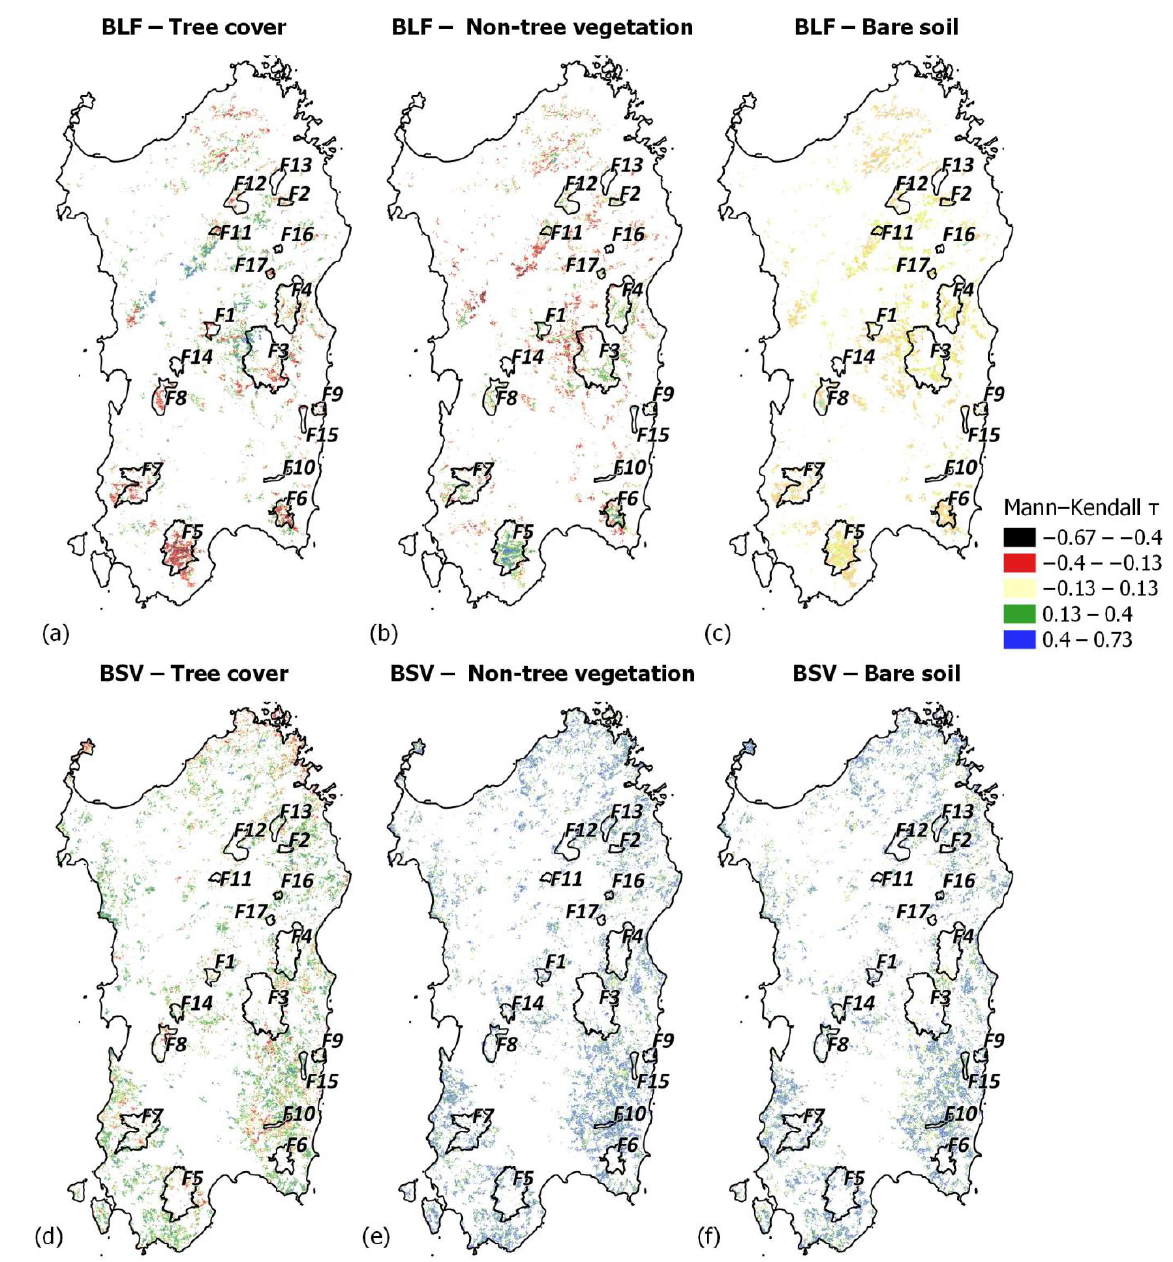
Figure 4. Mann‒Kendall τ of the percentage of tree cover ( a ), non-tree vegetation ( b ), and bare soil ( c ) for all the observed pixels classified as broad-leaved forests (BLFs), and of the percentage of tree cover ( d ), non-tree vegetation ( e ), and bare soil ( f ) for all the observed plots classified as bushy sclerophyllous vegetation (BSV) over the 20-year period (2000–2019). The thin black outlines indicate the 17 forests analyzed. The relative p -values are shown in Supplementary Figure S1.